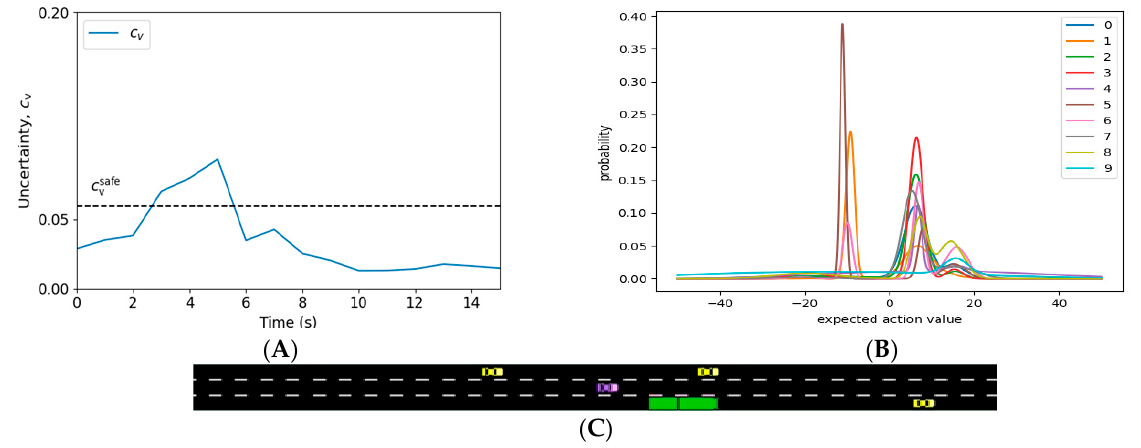
Figure 6. Uncertainty estimation result for speeding scenario: ( A ) uncertainty result, ( B ) Gaussian mixture at maximum uncertainty when 𝒄 𝒗 is highest, and ( C ) traffic condition display when 𝒄 𝒗 is highest.